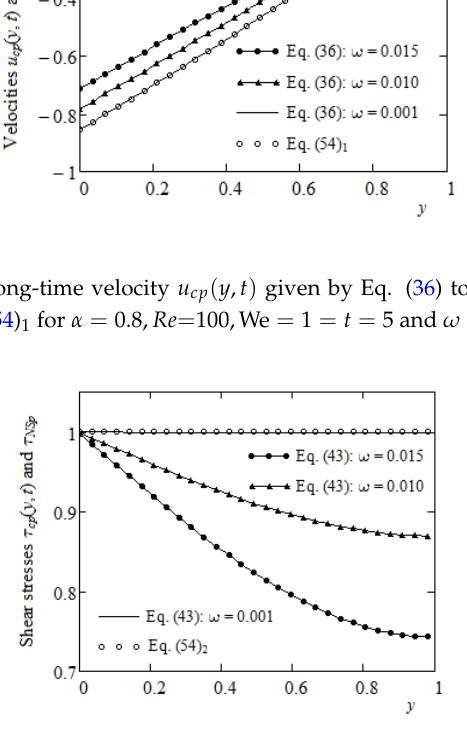
Figure 2. Convergence of the long-timee shear stress τ cp ( y , t ) given by Eq. (43) to the corresponding Newtonian